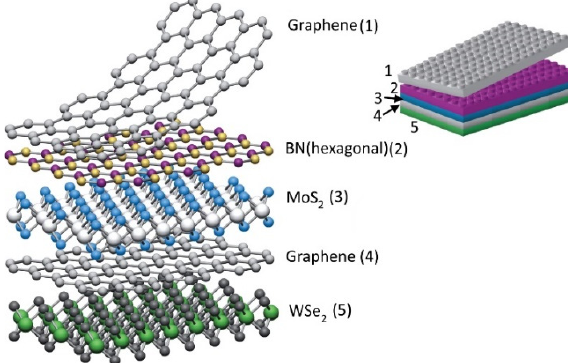
Figure 3. Layer-by-layer formation of a heterostructure based on graphene and other two-dimensional materials. Adapted by permission from Springer Nature [20], copyright © 2013.